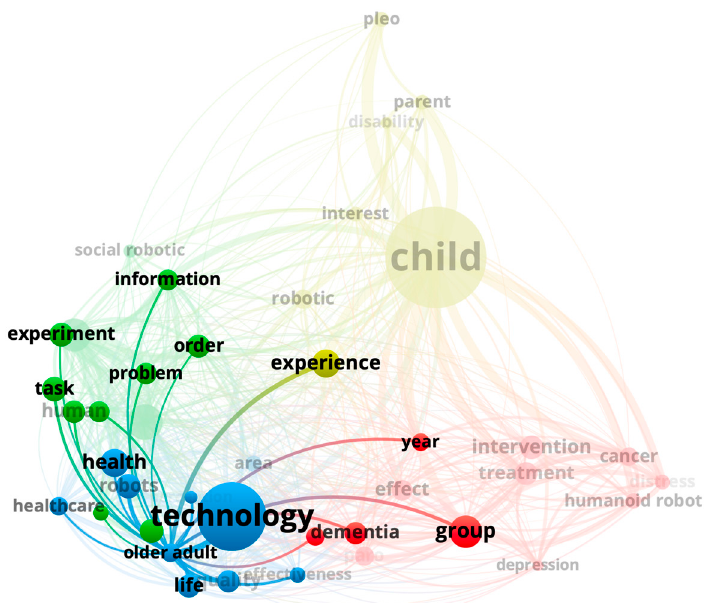
Figure 4. Details of the older adult cluster.